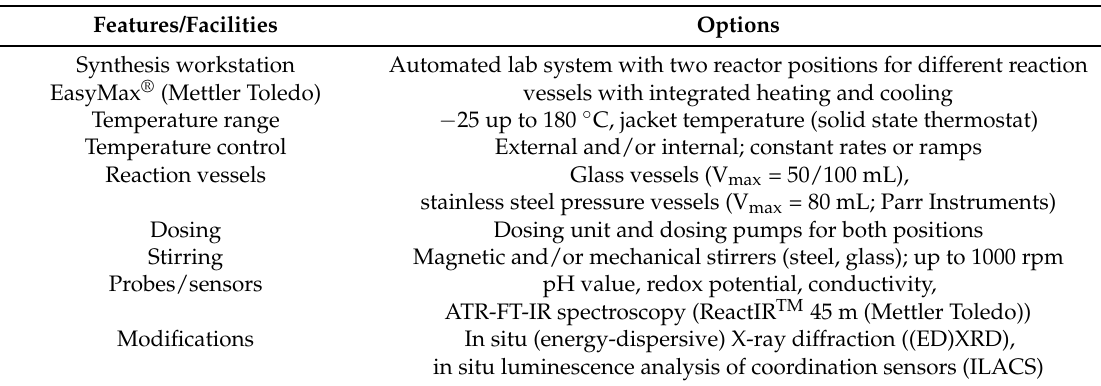
Table 1. Selected data of the in situ crystallization